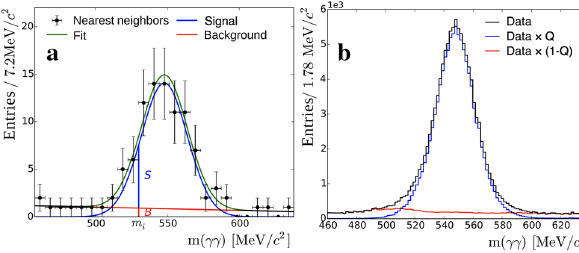
Fig. 2 Performance of the Q -factor method for background below the η signal appearing in the reaction ¯ pp → π 0 π 0 η . a Shows the invariant two-photon mass for 100 nearest neighbors of a selected π 0 π 0 η event. The greencurve shows the totalfit result. Theblue and redshapes repre- sent the signal and background contributions, respectively. The vertical line denotes the position of the actual event. b Shows the invariant two- photon mass for all events after application of the Q -factor method for the identified signal (blue) and background (red) components